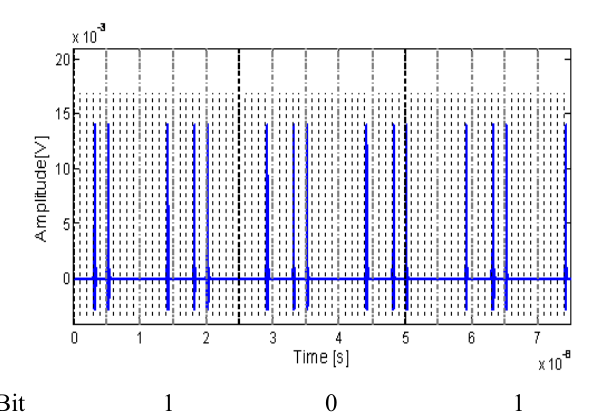
Fig.11. Reference transmitted signal using fifth derivative Gaussian pulse